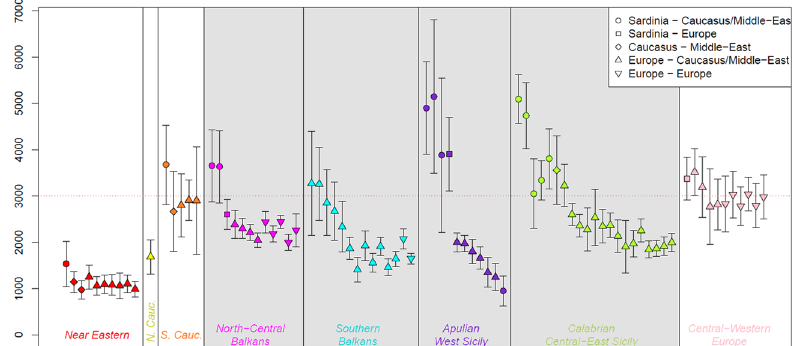
Figure 5. Inferred events and times of admixture. All possible trios of the 14 genetic-based clusters identified by ChromoPainter/fineSTRUCTURE analysis were tested for admixture with the f3 -statistics and dated with Alder. Admixture events resulting statistically significant for both f3 and Alder are detailed in Supplementary Table S7 and visually summarized in this time-line plot following the same listing order. Each vertical coloured line indicates an admixture event for the corresponding genetic cluster; points and bars-width reflect the estimated dates of admixture and relative SE. Different symbol-codes have been used based on the regional ancestry of the pairs of source populations involved in each admixture event (as in the legend at the top-right). Admixture events involving Southern Italian and Southern Balkan clusters are included in the grey